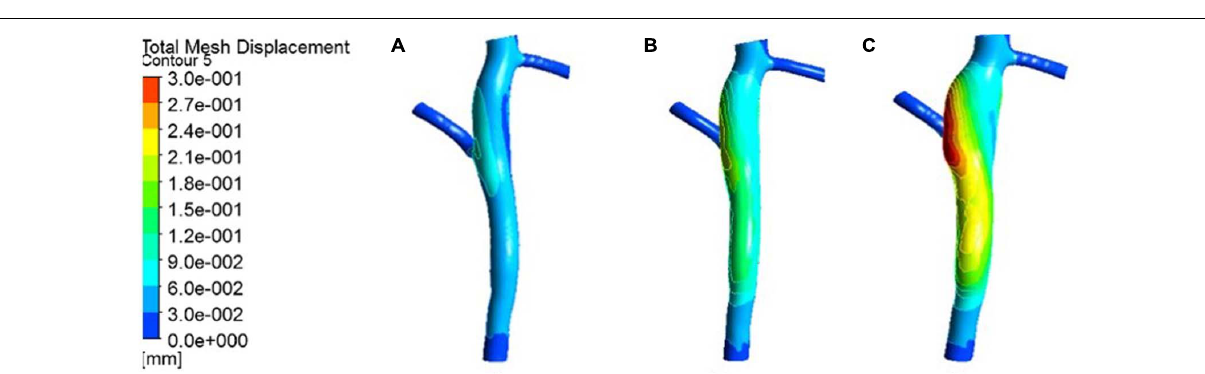
FIGURE 7 | Deformation contour of the LCX in maximum time. (A) normal condition; (B) the Young’s modulus of the atherosclerotic site is 0.27MPa; (C) the Young’s modulus of the atherosclerotic site is 0.027 MPa.